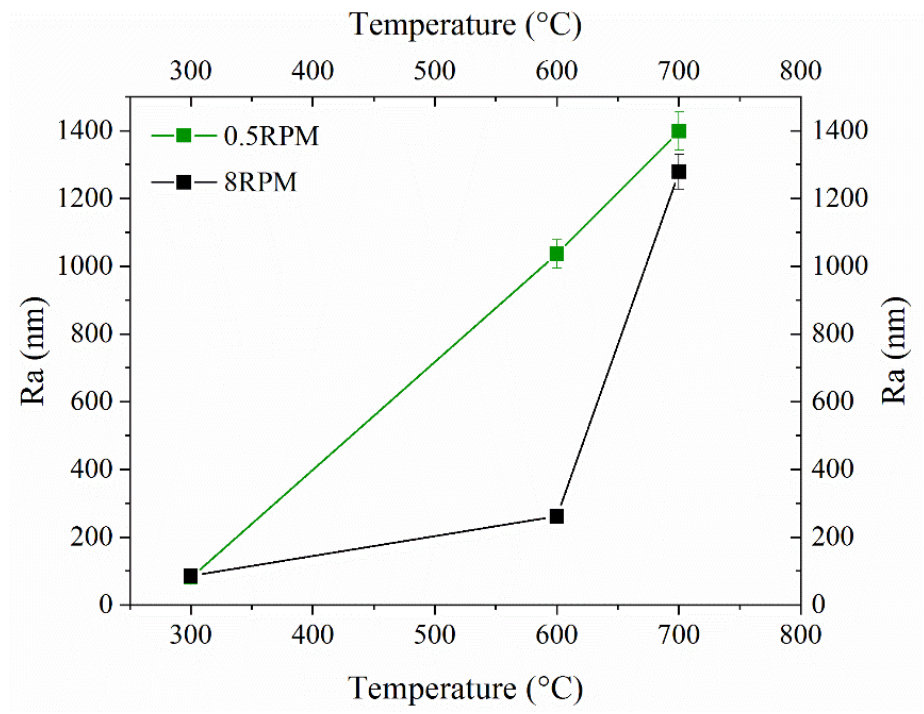
Figure 4. Roughness of the multilayer coatings oxidized at different temperatures. The multilayer coating deposited at 0.5 RPM rotation (Figure 3a–c) and then oxidized at 600 ◦ C for 15 min demonstrate an almost totally rough oxidized surface in Figure 3b as compared to that obtained at 8 RPM (Figure 3e) which looks as almost the same as that in Figure 3c. The 0.5 RPM (Figure 3b) and 8 RPM (Figure 3e) oxidized coatings demonstrated roughness’s 1 µ m and 262 nm, respectively (Figure 4). It seems that the coating deposited at 8 RPM rotation demonstrated more resistance with respect to medium temperature oxidization as compared to that of deposited at low rotation rate of 0.5